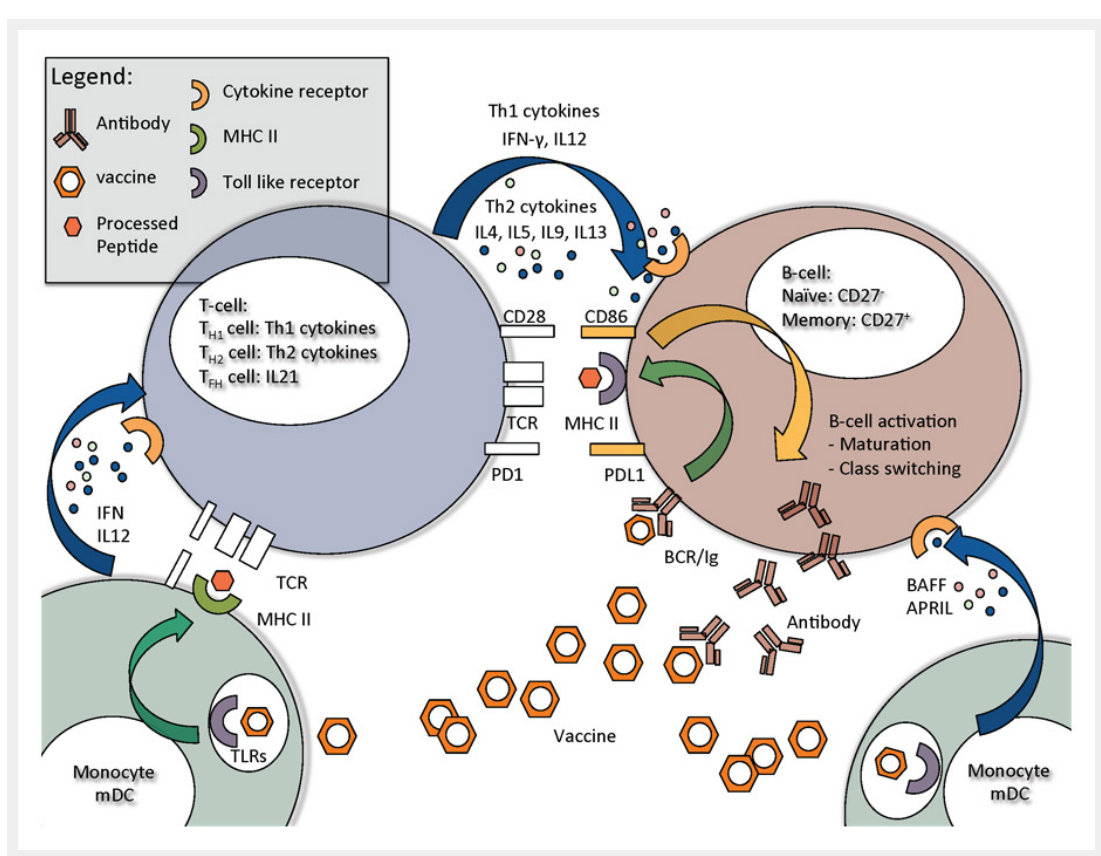
Key steps in B-cell activation and B-cell interaction with T-helper cells and monocytes, and monocyte derived macrophages and dendritic